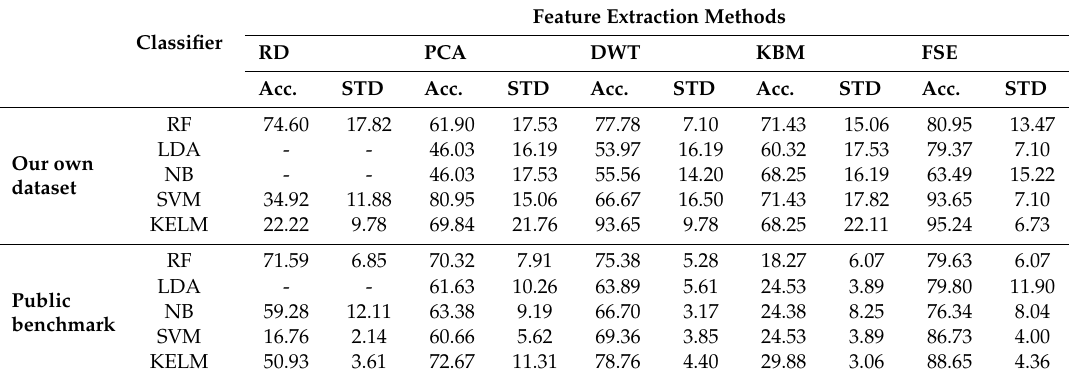
Table 1. Accuracy and standard deviation of models